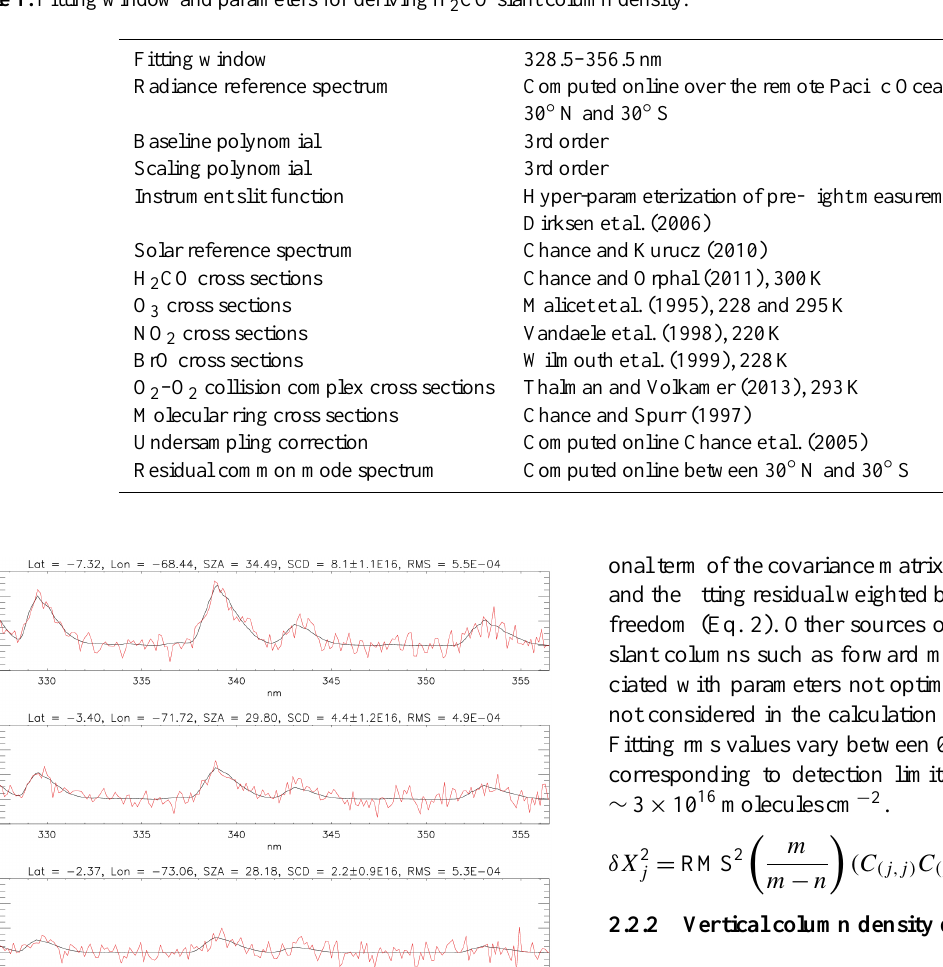
Table 1. Fitting window and parameters for deriving H 2 CO slant column density.